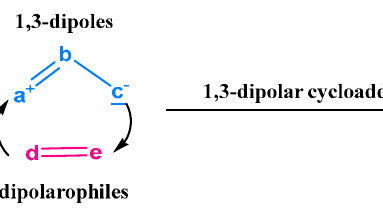
Figure 2. Diazpropane DAP and dipolarphile DP structures. Figure 1. Huisgen reaction mechanism.